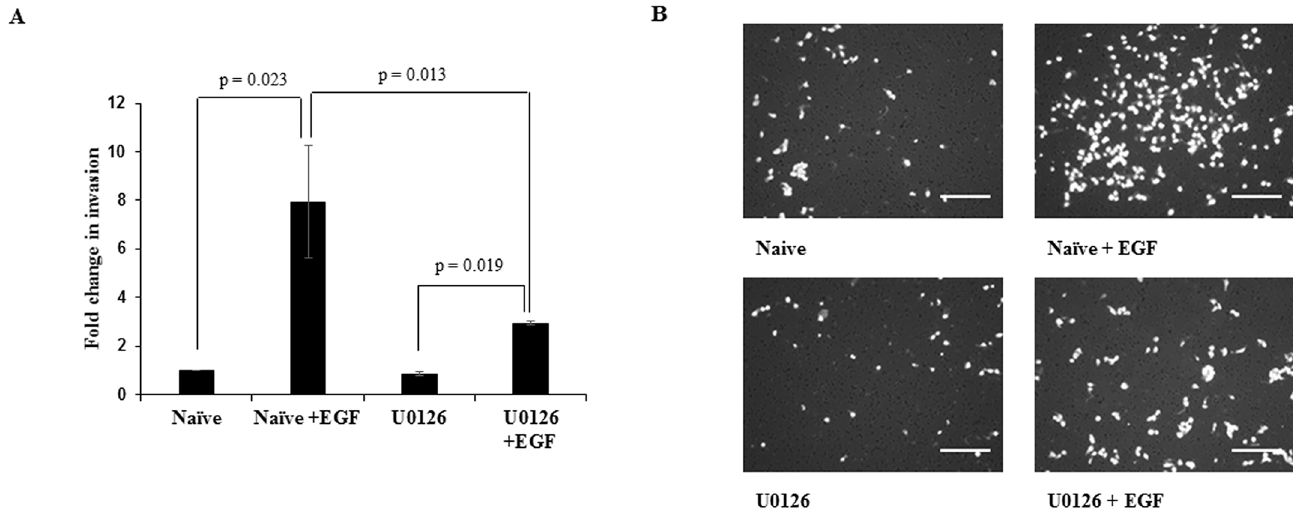
Fig 3. Effect of U0126pre-treatment of HTR-8/SVneo cells on invasion in presenceor absence of EGF. FollowingU0126 pre-treatment of HTR- 8/SVneo cells, invasionassay was performed either in presenceor absenceof EGF (10 ng/ml) as describedin Materials and Methods . Panel A shows relative fold changein invasionof varyingtreatment groups (EGF treated, U0126pre-treatedand U0126pre-treatedcells treated with EGF) as comparedto the untreatedna ï veHTR-8/SVneo cells. Valuesare expressedas mean ± SEM of three independentexperiments performed in duplicates. Panel B has representative photographsof invadingcells in various treatment groups (na ï ve,EGF treated, U0126pre-treatedand U0126 pre-treatedcells with EGF treatment) on 0.8 μ m pore size transwellmembranes as observed under microscope after processingfor invasionassay. Scale bar represents5 μ